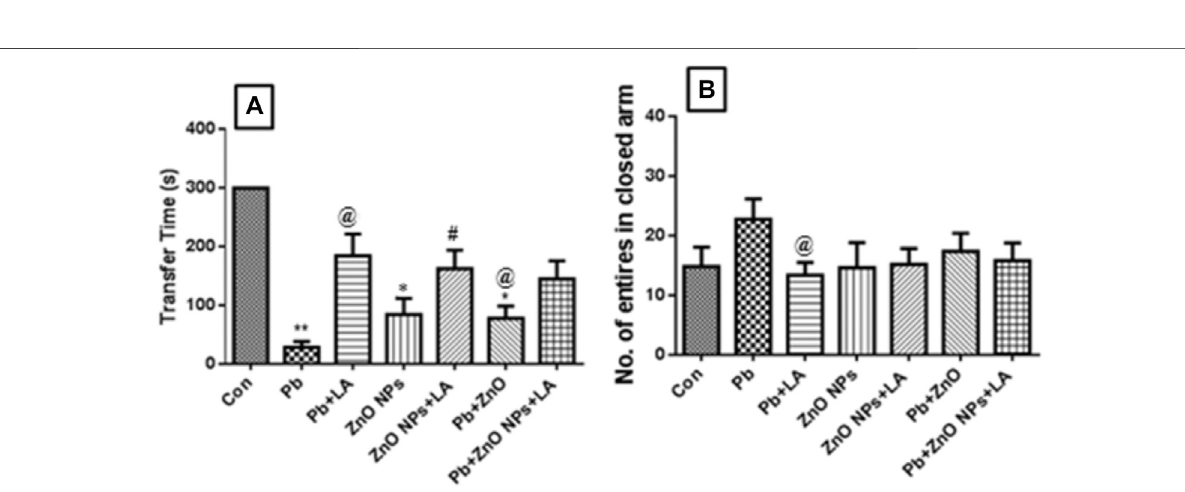
Frontiers in Pharmacology |